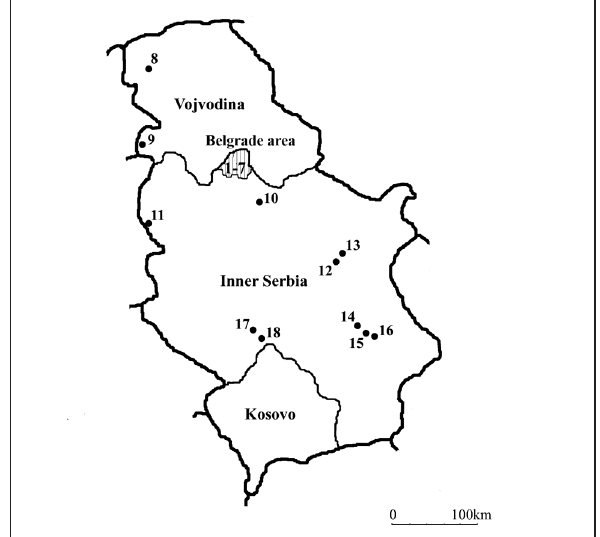
Fig. 1. – Map of Serbia with tick collection sites (Sites 1 to 7 – Belgrade area; 8, 9 – Vojvodina; 10 to 18 – Inner